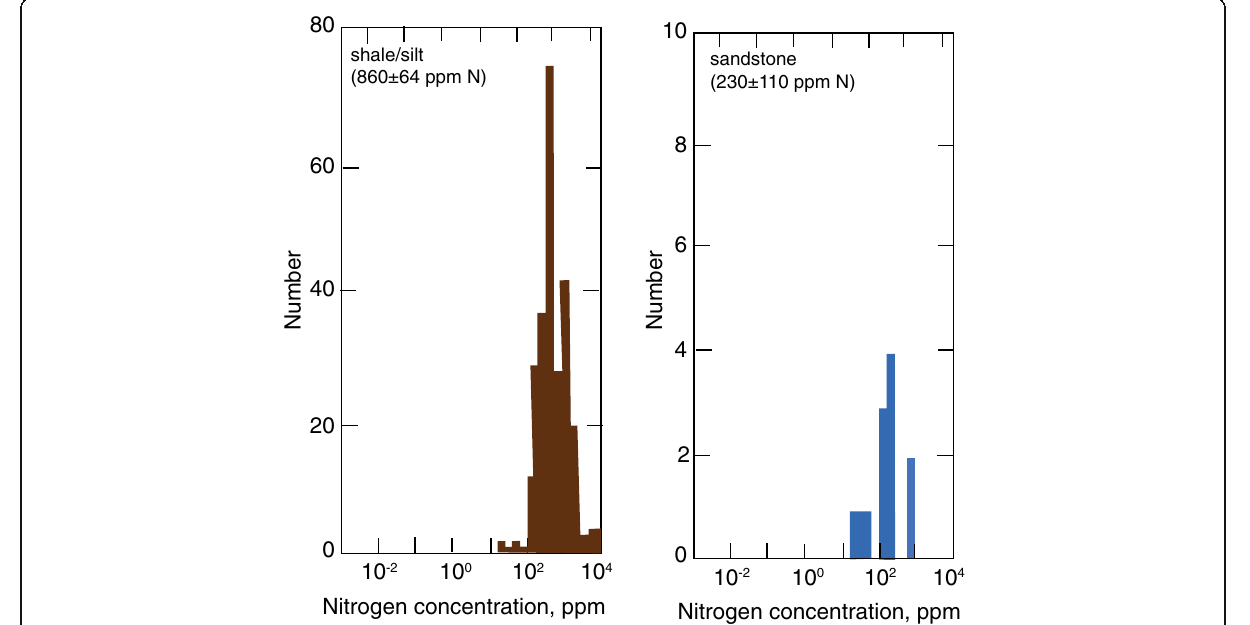
Fig. 2 Distribution of nitrogen concentrations in various oceanic sedimentary rocks modified after Johnson and Goldblatt